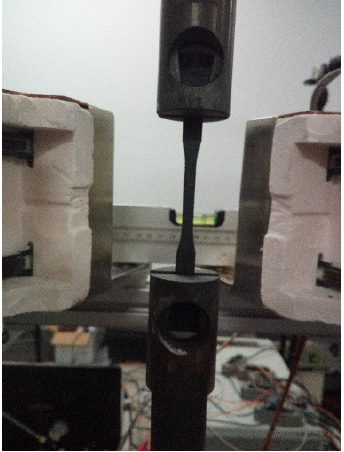
Figure 10. The experimental system and the installation of the specimen.